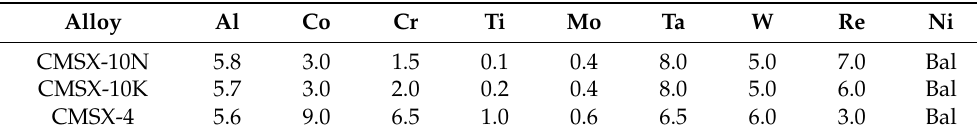
Table 1. The general composition of the three alloys used [9]. CMSX-4 and CMSX-10 are registered trademarks of Cannon-Muskegon